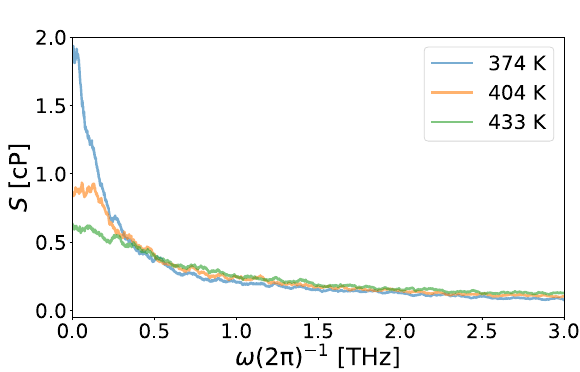
Fig. 7 Moving average of the low-frequency region of the power spectrum of the off-diagonal elements of the stress tensor in water at different temperatures, as obtained from DPMD simulations trained on PBE DFT data. An averaging window of 0.05 THz was used. Simulations were run at the fi xed density of 1 gr cm − 3 .